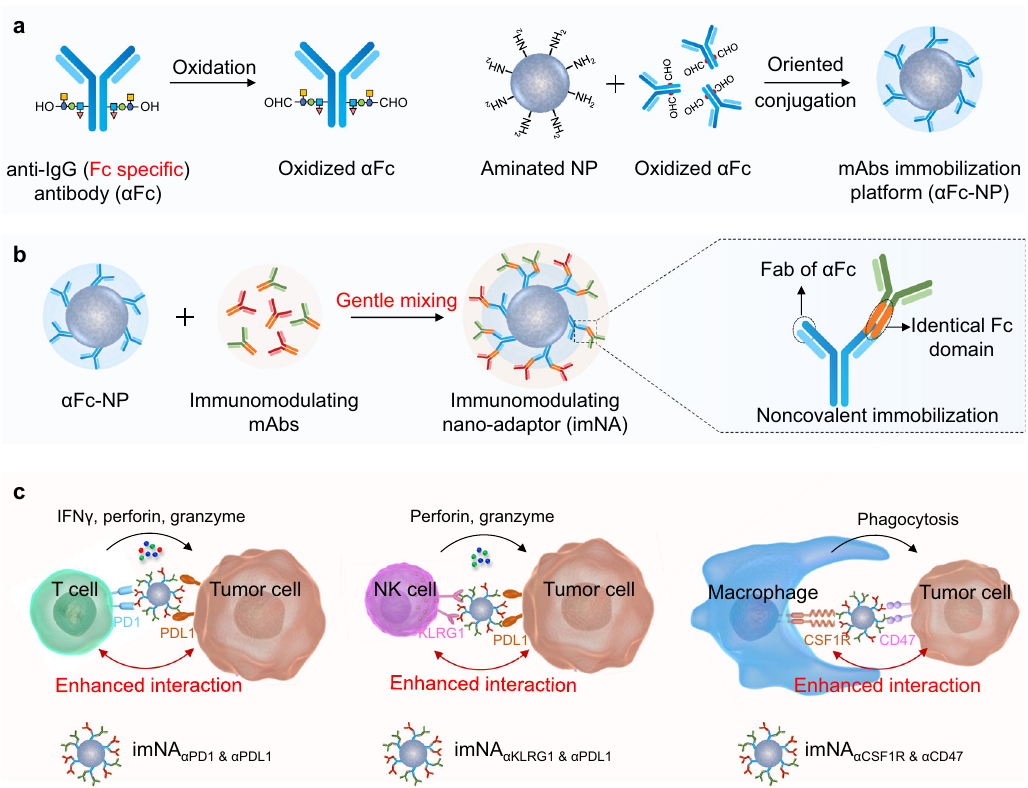
Fig. 1 Schematic illustrating the design of imNAs and their potential to improve antibody-based cancer immunotherapy. a An anti-IgG (Fc speci fi c) antibody ( α Fc) was oxidized and oriented conjugated onto the surface of nanoparticle to form an antibody immobilization platform ( α Fc-NP). b Two types of immunomodulating monoclonal antibodies (mAbs) that target effector cells and tumor cells could be immobilized onto α Fc-NP after gentle mixing via Fc recognition. The constructed formulations could serve as immunomodulating nano-adaptors (imNAs) as they potentially associate with effector cells and tumor cells simultaneously and bridge them together like an ‘ adaptor ’ while maintaining the immunomodulatory properties of the parental mAbs. c The versatility of α Fc-NP and superiority of imNAs were validated in T cell-, natural killer cell- and macrophage-mediated antitumor immune responses in multiple murine tumor